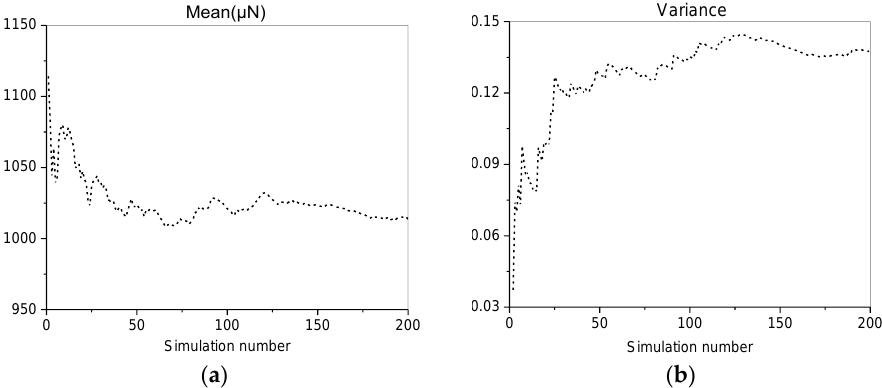
force of the finished model were calculated. Convergence of the mean and variance was